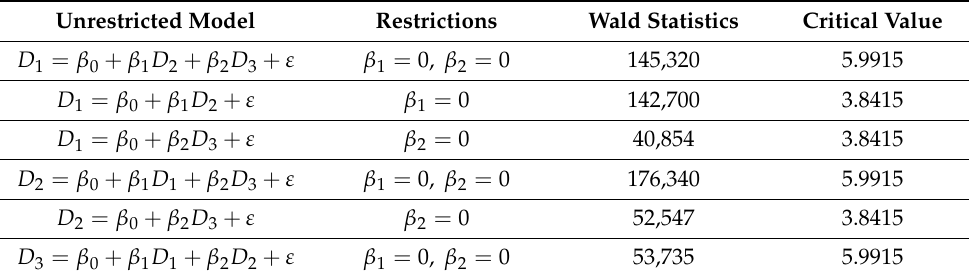
Table 3. The Wald test statistics for the deviations D 1 - D 3 of reaction times for Questions 1–3, respectively, at the significance level of 0.05, β 1 , β 3 are the constant values, and ε is the normally distributed error with a mean of 0 and a variance of 1.